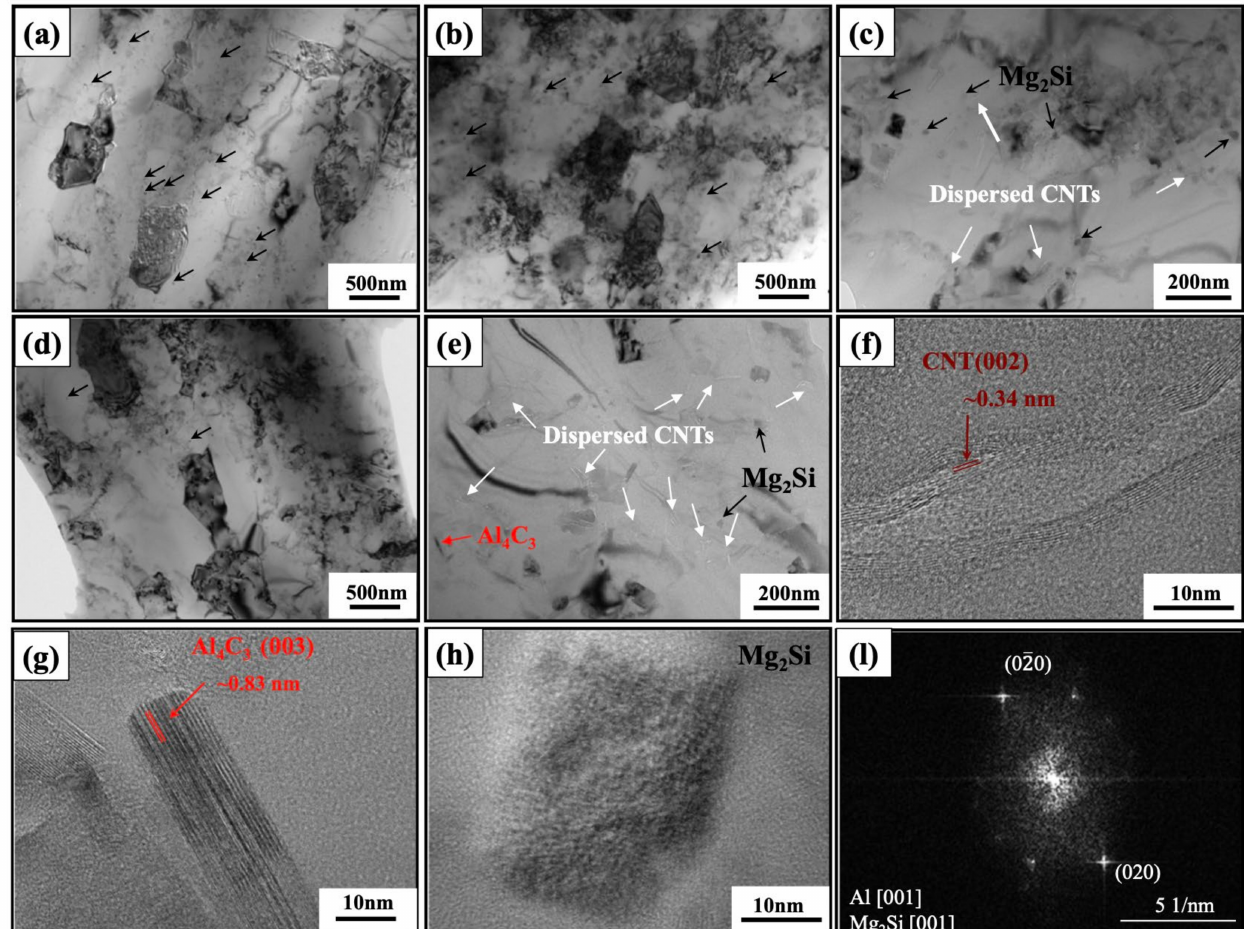
Figure 16. TEM and HRTEM images and FFT of 6061Al/CNT, showing the presence of dispersed CNT and Al 4 C 3 and Mg 2 Si phases. ( a ) 6061Al-T6 sample, ( b , c ) 0.5 wt.% CNT/6061Al-T6 sample and ( d , e ) 1.5 wt.% CNT/6061Al-T6 sample, ( f ) HRTEM image of a CNT present in ( e ), ( g ) HRTEM image of an Al 4 C 3 particle present in ( e ), ( h ) HRTEM image and respective ( l ) FFT patterns of Mg 2 Si precipitate present in ( e ). The black arrows indicate the Mg 2 Si precipitate. Reproduced from [98] with permission from Elsevier,